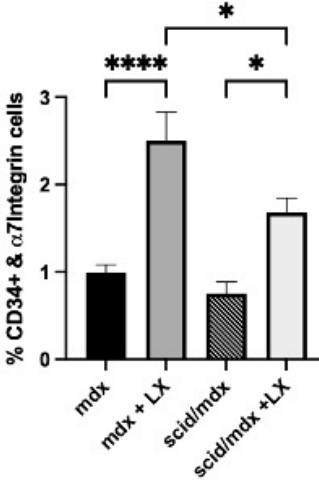
10 of 22 Figure 8. SPL Inhibition improves skeletal muscle function. Grip strength of vehicle-treated (control, CTR) and LX2931-treated (LX) mdx pups at 6 weeks of age measured using a grip strength meter. C/T = compression/tension. Values are normalized to body weight in grams (g). Mean ± SD; * p < 0.05; n = 8–10/group. 2.8. SPL Inhibition Promotes SC Expansion in Immunodeficient Mdx Mice Inhibition of SPL and S1P1 antagonism both block T lymphocyte egress, causing the depletion of circulating T cells; however, unlike the S1P1 antagonists, SPL inhibition also reduces infiltrating neutrophils and monocytes. To delineate the contribution of the lym- phocyte-specific effects of SPL inhibition on SC expansion in mdx mice, LX2931 was ad- ministered using the perinatal delivery method to mdx mice and to SCID/mdx mice, which lack T and B cells. The SC abundance was then compared by flow cytometry of the